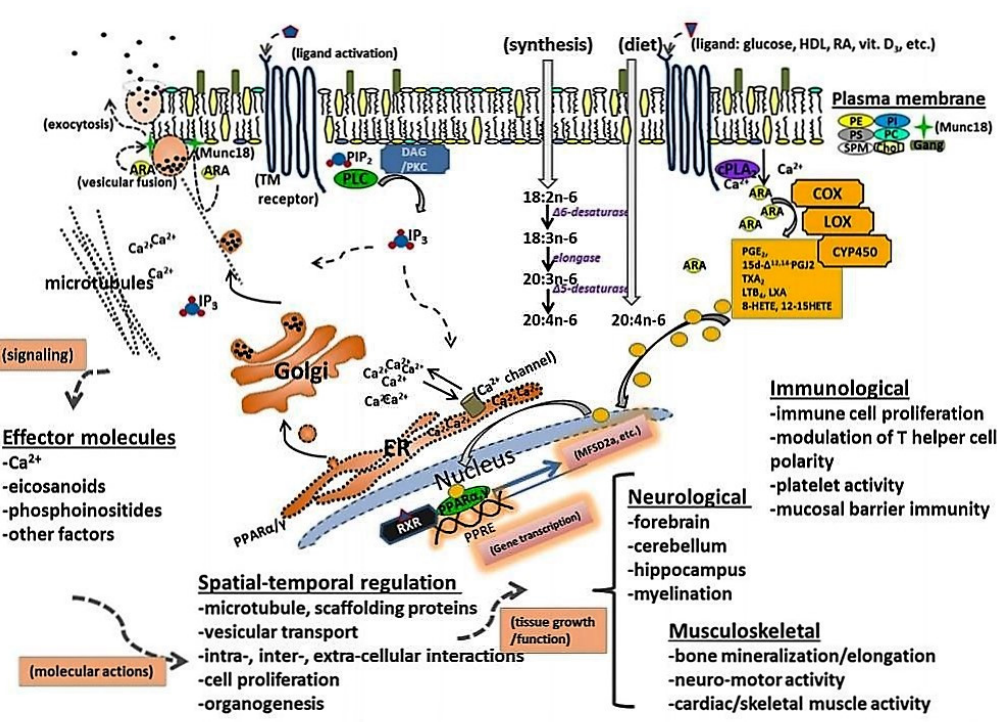
Figure 7. Schematic summary of molecular events and functional outcomes involved in metabolism of ARA. ARA is derived from endogenous synthesis or directly from the diet and is incorporated into cellular membrane complex lipids. Within the lipid bilayer, ARA is enriched in PE and PI in the inner membrane. Coordination of spatial-temporal interactions between molecular and cellular components and activities are mediated by metabolites of, or molecules associated with metabolism of ARA. Metabolism of ARA is triggered by activation of transmembrane receptors as a result of binding a ligand. A few examples of receptor-mediated activation of ARA metabolism include glucose, vitamin D 3 , Ca 2+ , or antigen presentation or detection by immune cells. ARA released from the membrane by the actions of PLA 2 or metabolized by enzymes such as COX, CYP450, and/or LOX can act directly or serve as a substrate for various enzymes to produce second-messengers. ARA-derived eicosanoids, including prostaglandins, leukotrienes, lipoxins, and HETEs regulate numerous activities including passage of ions between subcellular compartments, interactions between various structures or cells, and nuclear regulation of gene transcription by PPARs activators. Within the inner leaflet of cell membranes, ARA is enriched in micro-domains and is involved in regulation of receptor mediated activities. In addition, micro-domains serve as foundations for biophysical interactions between subcellular structures such as microtubules and other cytoskeletal activities including vesicular transport. The consequences of temporal-spatial regulation include coordinated release of hormones, expression of various cell functions, and/or alterations in phenotypes, and cellular motility. Examples of PPAR-regulated gene products involved tissue uptake of LCPUFA and oxidation of stored lipids: MFSD2A, major facilitator of superfamily domain-containing protein 2A. Membrane components: Chol, cholesterol; Gang, gangliosides; PC, phosphatidylcholine; PE, phosphatidylethanolamine; PI, phosphatidylinositol; PS, phosphatidylserine; SPM, Sphingomyelin. Nuclear transcription factors: PPAR, peroxisome-proliferator activator receptors; RXR, retinoid X receptors. TM, transmembrane receptors. Enzymes: COX, cyclooxygenase; CYP450, cytochrome P450; LOX, lipoxygenase; PLA 2 , Phospholipase A2; PLC, Phospholipase C. Signaling molecules: PG, prostaglandin (Adapted from Pike